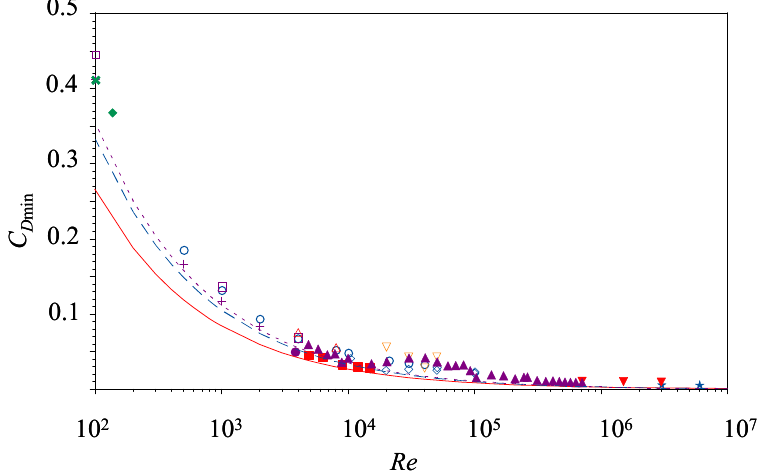
Fig. 5 C versus Re. See Table 1 for symbol’s D min